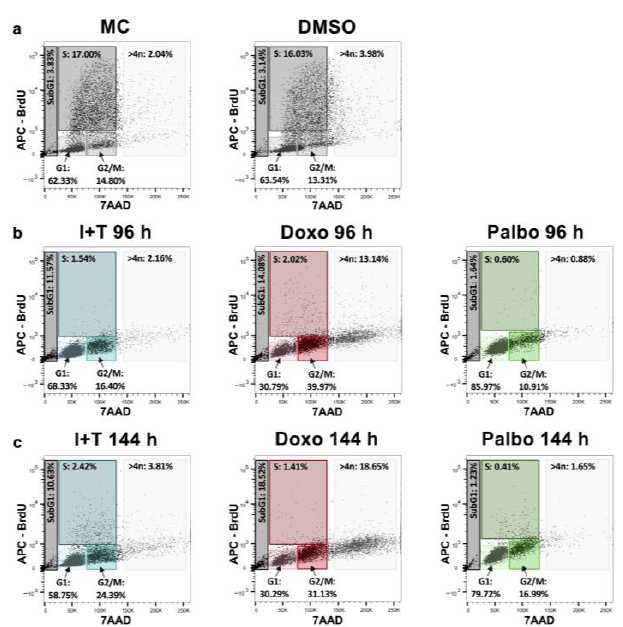
Figure A1 . Differential cell cycle arrest induced by cytokines, doxorubicin, and palbociclib. ( a – c ) Representative plots depicting the distribution of WM115 cells in different phases of the cell cycle (subG1, G1, S, G2/M, >4n) upon treatment with IFN- γ and TNF (I+T), doxorubicin (Doxo), and palbociclib (Palbo) and respective controls as indicated. MC, medium control. DMSO, vehicle control. Flow cytometric analysis was performed after the 96 h treatment ( a , b ) and 48 h after the end of treatment (144 h; c ).